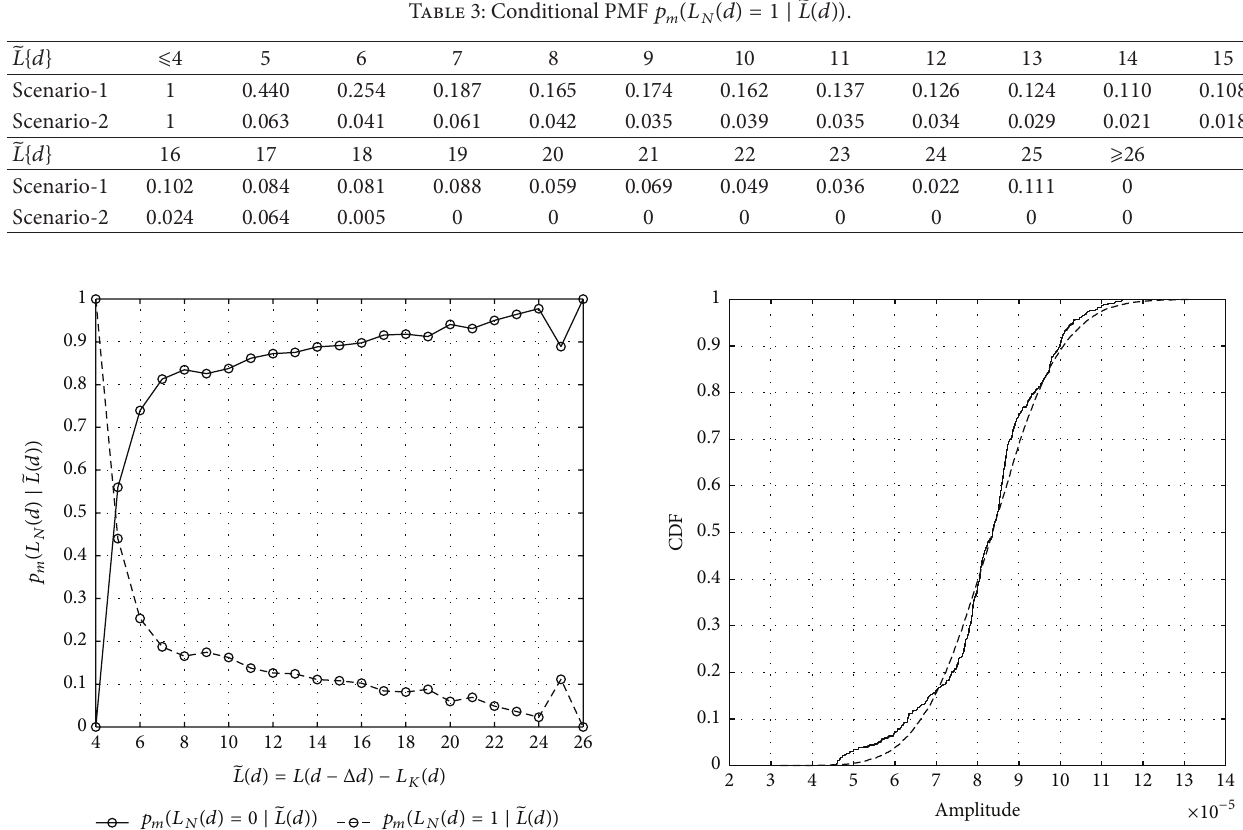
̃𝐿(𝑑)) with Δ𝑑 = 3 mm for